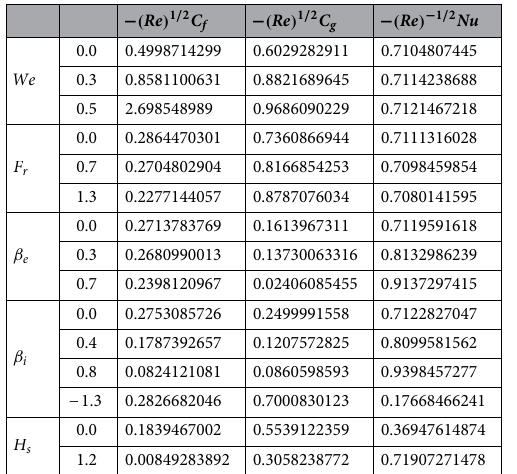
Table 4. Numerical values of gradient temperature and skin friction coefficients versus various